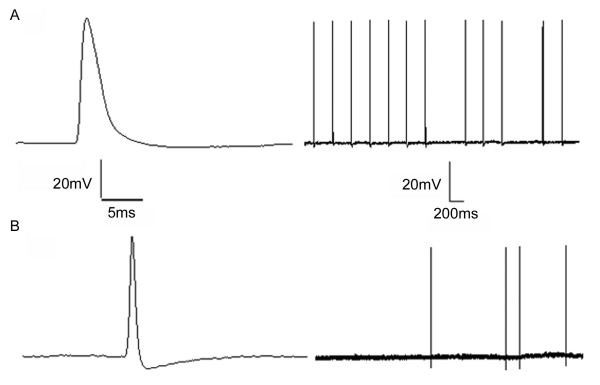
Persisting discharge in response to stimulation of the peripheral receptive field in neuropathic rats. This figure shows a persisting discharge seen in DRG neurons in neuropathic rats that was not observed in control rats-an Aβ-fiber HTM neuron (A), Aβ-fiber hair neuron (B). The APs on the left are the first AP in the on-going discharge shown on the right at a slower sweep speed.